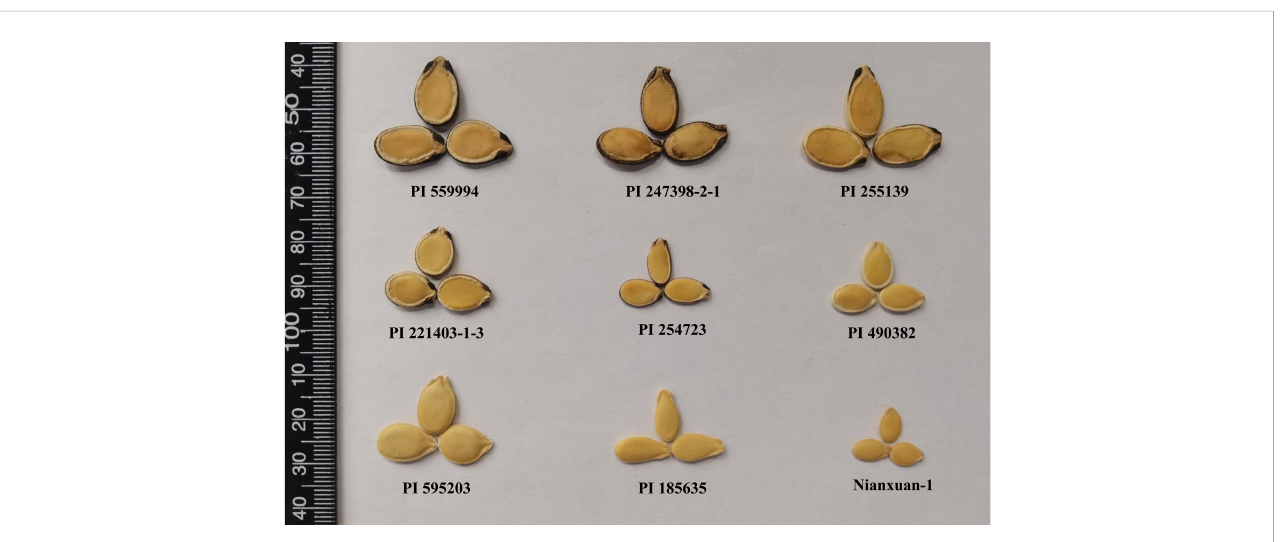
FIGURE 1 Different egusi seed types for egusi